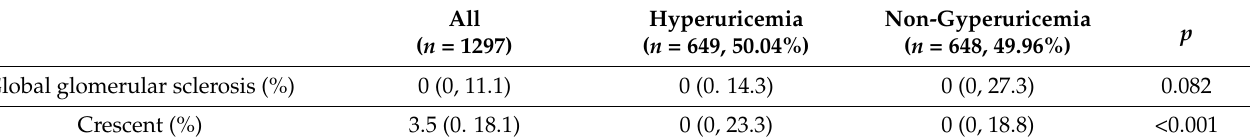
Table 2. Pathological characteristics of LN (lupus nephritis) patients in the hyperuricemia and non-hyperuricemia